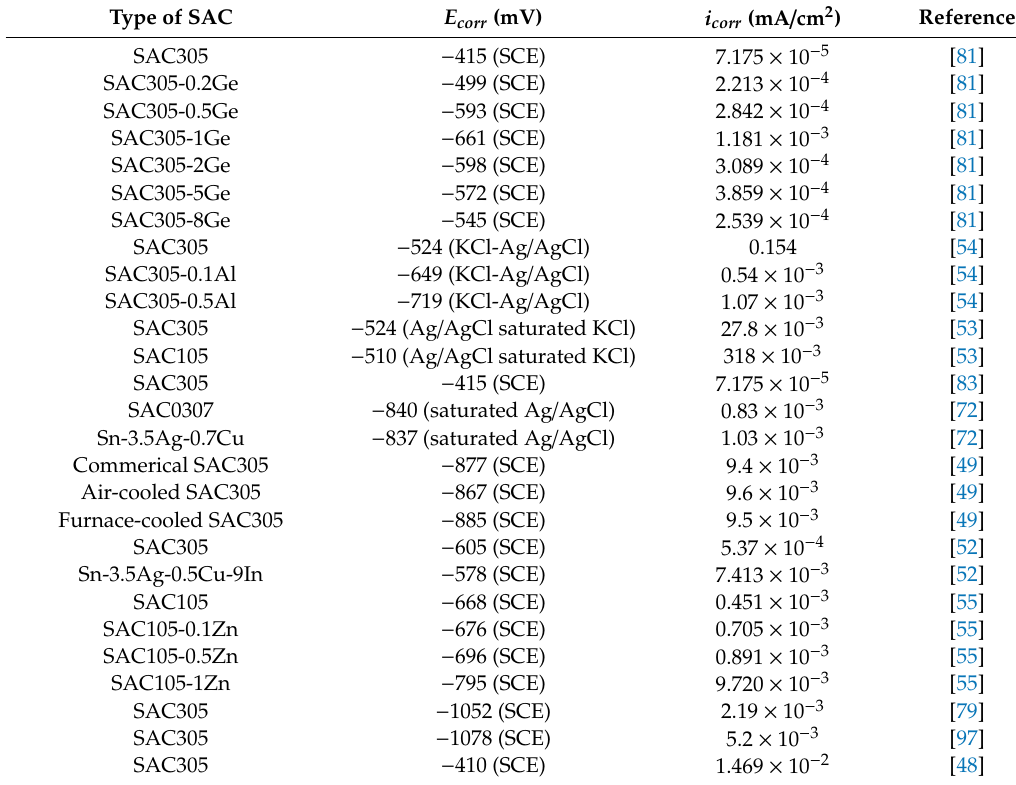
Table 2. Experimental data of SAC alloys after Linear Sweep Voltammetry (LSV) in 3.5 wt % NaCl